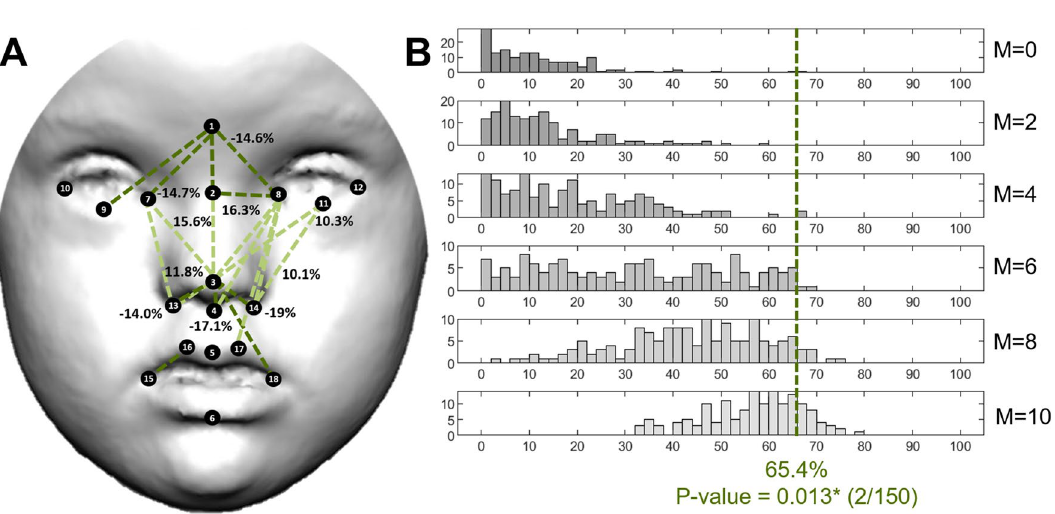
Figure 3. Localized Euclidean Distance Matrix Analysis facial shape pairwise contrasts and iterative bootstrapping tests of facial dysmorphology between controls and individuals diagnosed with Morquio syndrome. From top to bottom histograms, the simulations included 0, 2, 4, 6, 8 and 10 patients. For more details see legend in Fig. ranged from 5 to 11%, with a similar magnitude as in DS (Fig. 4A). FDS indicated that 47.7% of facial traits were significantly different in NS (Fig. 4B). Neurofibromatosis type 1 was associated with minor facial dysmorphologies, which were less abundant and less severe than in the previous syndromes (Fig. 5A). Individuals with NS only presented 11.4% of significantly different facial traits as compared to controls, and the percentages of relative change were low, mostly ranging from 1 to 5% (Fig. 5A,B). The largest difference was a 10% increase in facial distance between the glabella and the labiale superius (Fig. 5A). Along with larger distances in the midline of the face, EDMA detected reduced distances on the right and left sides of the face, with shorter distances from the right and left chelion to the eye landmarks, the endocanthion and the palpebrale inferius. Hypertelorism was not present in individuals with NF1 (Fig. 5A). In NF1, the FDS score was not significant (Fig. 5B), indicating that the facial dysmorphology